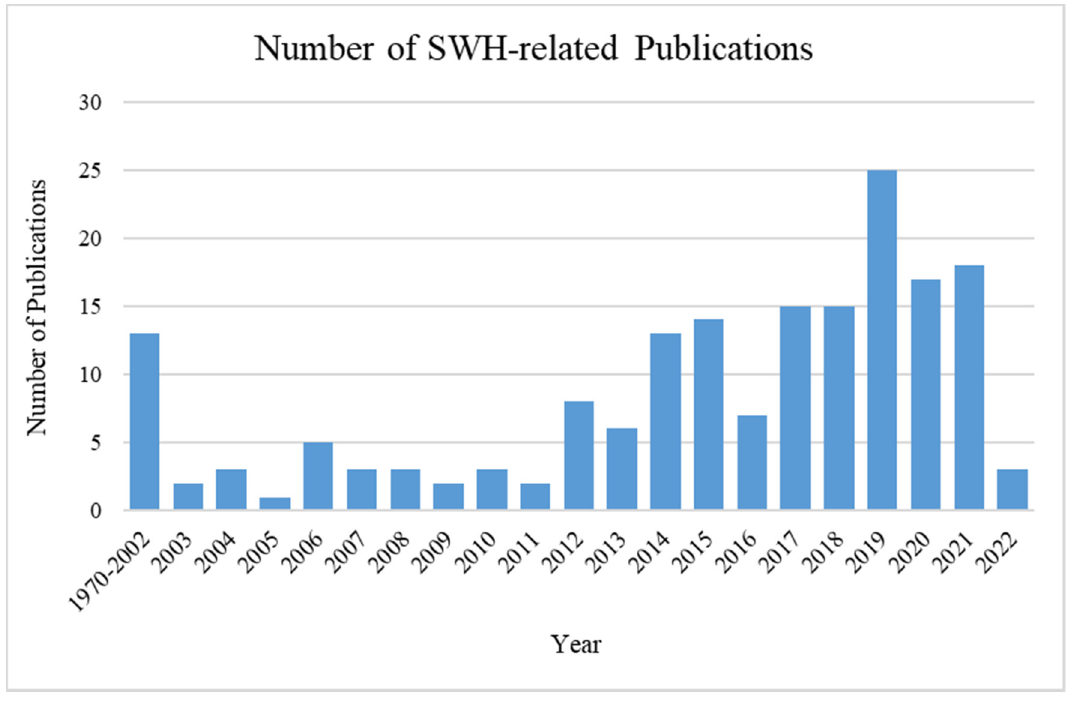
Figure 2. The trend of SWH studies over the years.